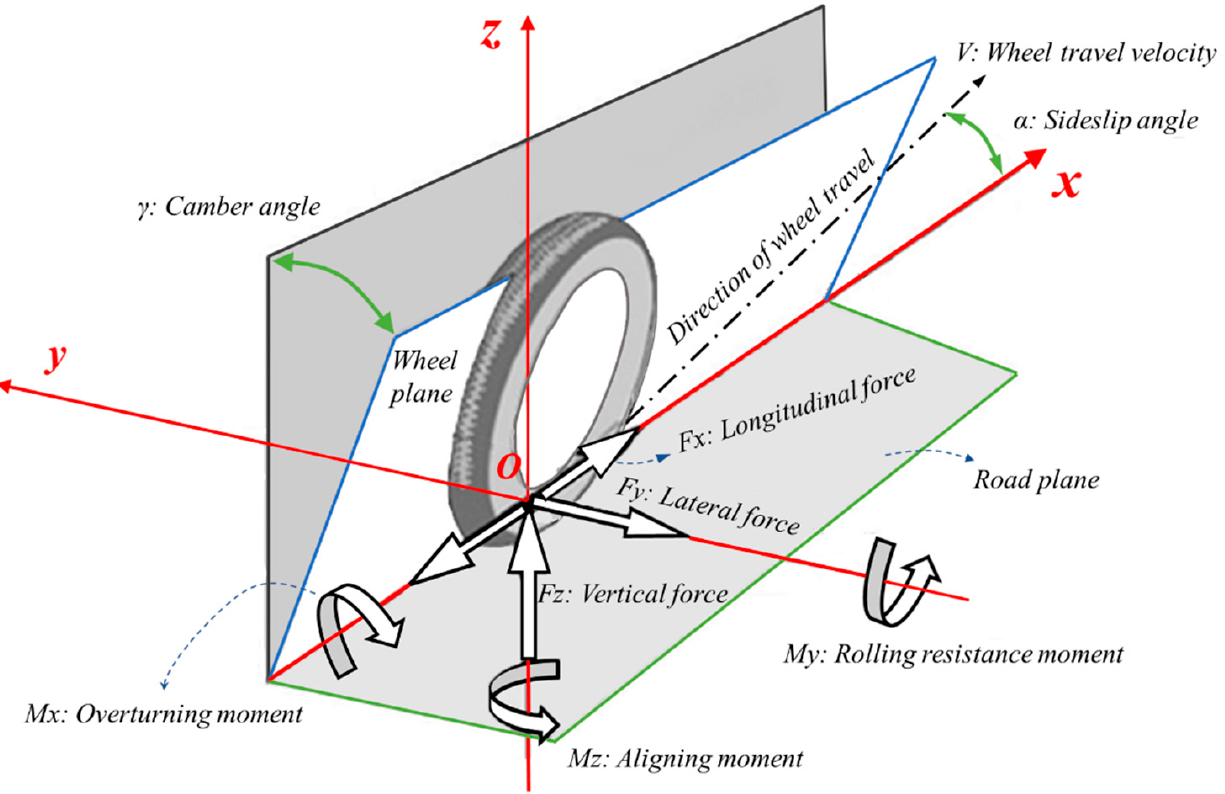
Figure 1. Motorcycle tire coordinates and parameters.